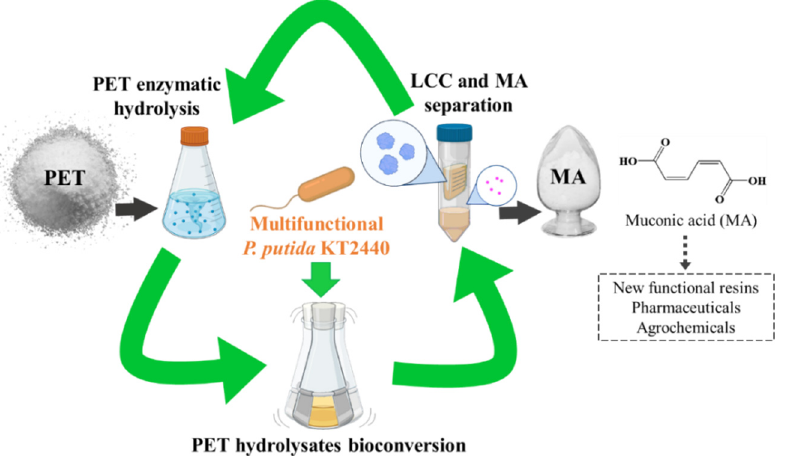
Figure 1. Conceptual scheme for conversion of PET to MA with an engineered multifunctional Pseudomonas putida . A leaf-branch compost cutinase (LCC) crude enzyme prepared from the culture supernatant hydrolyzes PET and produces the EG and TPA monomers, which can be directly used as substrates for the following cultivation to produce MA and reproduce LCC. The final product MA can be separated from the LCC crude enzyme by filtration. The remaining concentrated LCC crude enzyme was collected and used for the next round of PET hydrolysis with a stable activity, leading to the continuous conversion of PET to MA.